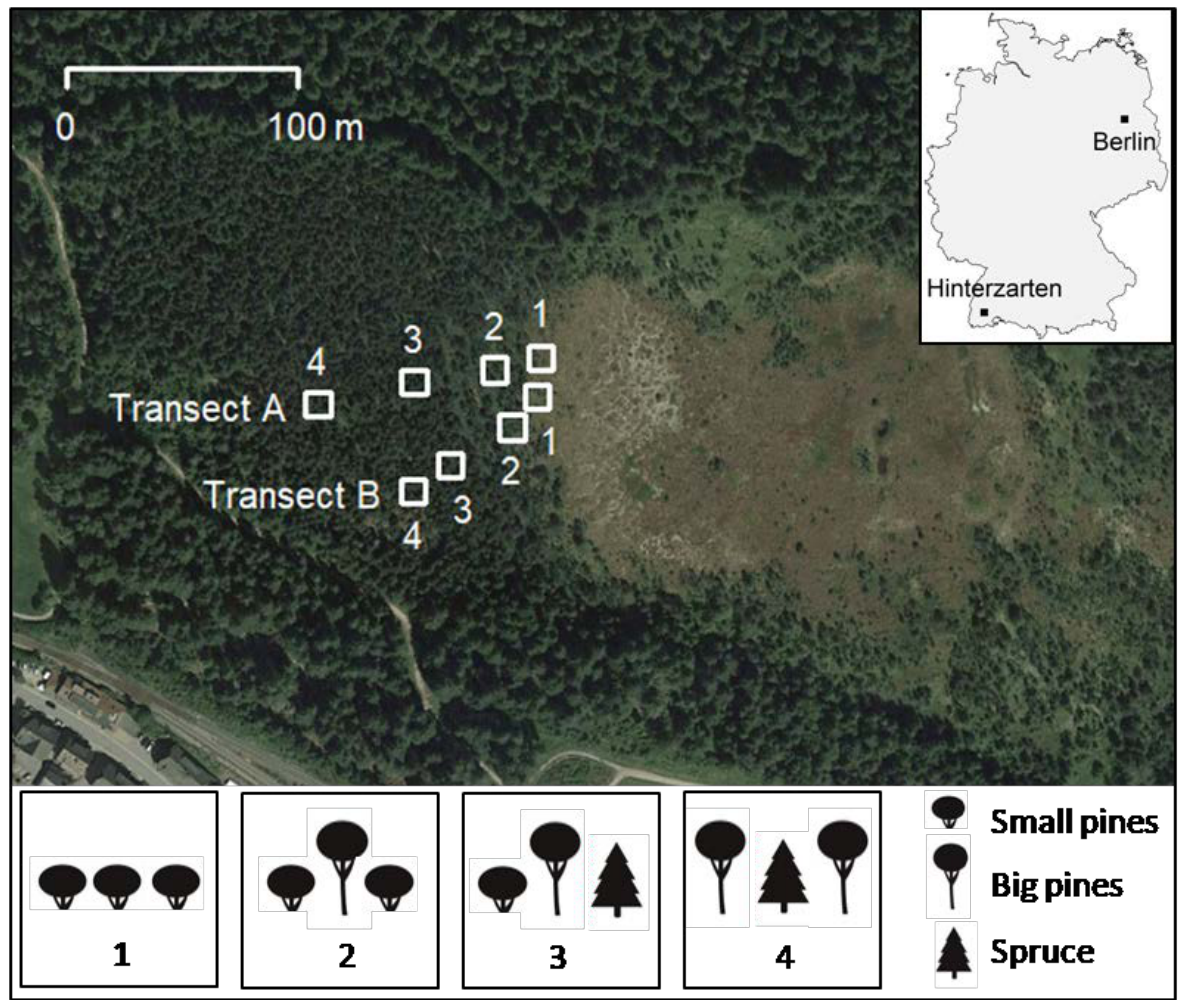
Figure 1. Western part of the ‘Hinterzartener Moor’, with the two transects from open centre of the bog (Position 1) to the bog margin (Position 4) and groups of trees present at the different plot positions shown. The railway tracks that caused drainage of the bog are visible in the lower left corner of the picture. Maps: R-packages ‘mapdata’ (Becker et al . 2016) and ‘RgoogleMaps’ (Loecher & Ropkins 2015). Sampling